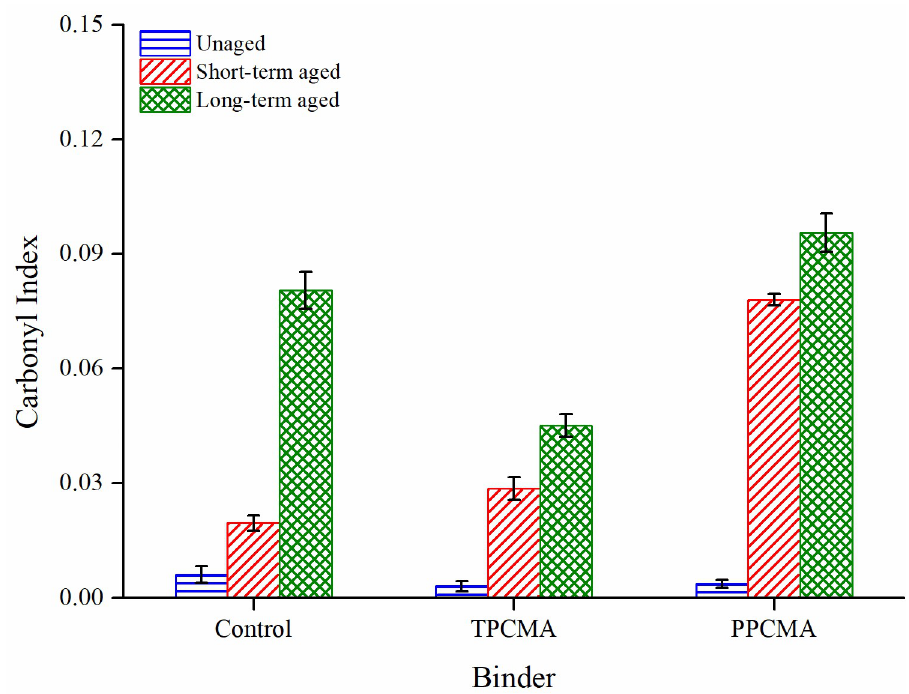
Fig 13. Carbonyl index under different aging states.